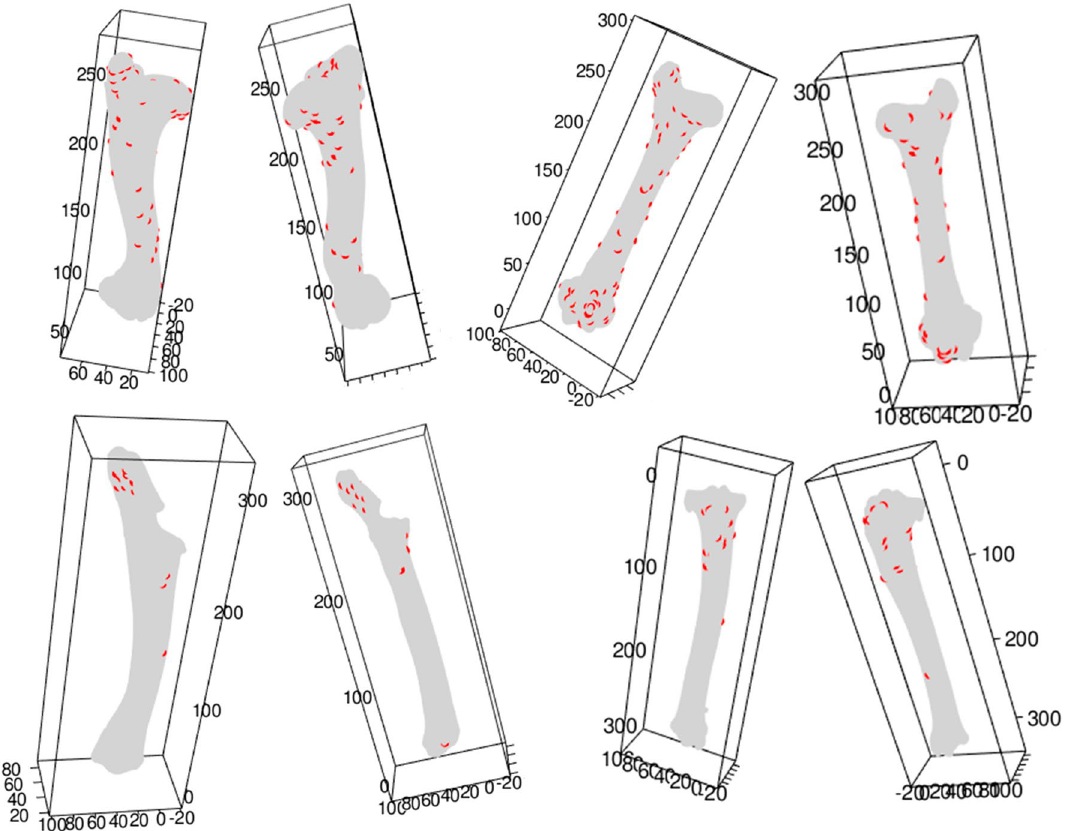
Figure 2. Examples of three-dimensional tooth mark distribution from the lion-consumed carcass sample on each of the four long bones. Distribution of marks is shown on bilateral